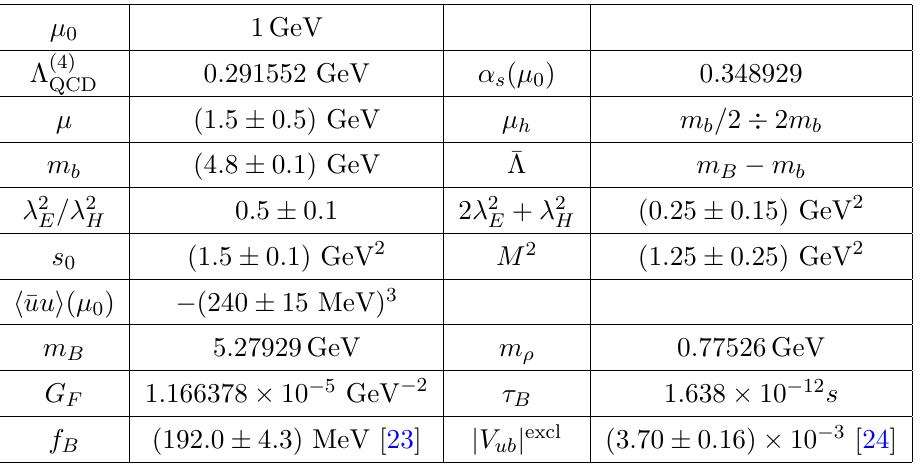
Table 1 . Central values and ranges of all parameters used in this study. The four-(cid:13)avour (cid:3) QCD parameter corresponds to (cid:11) s ( m Z ) = 0 : 1180 with three-loop evolution and decoupling of the bottom quark at the scale m b